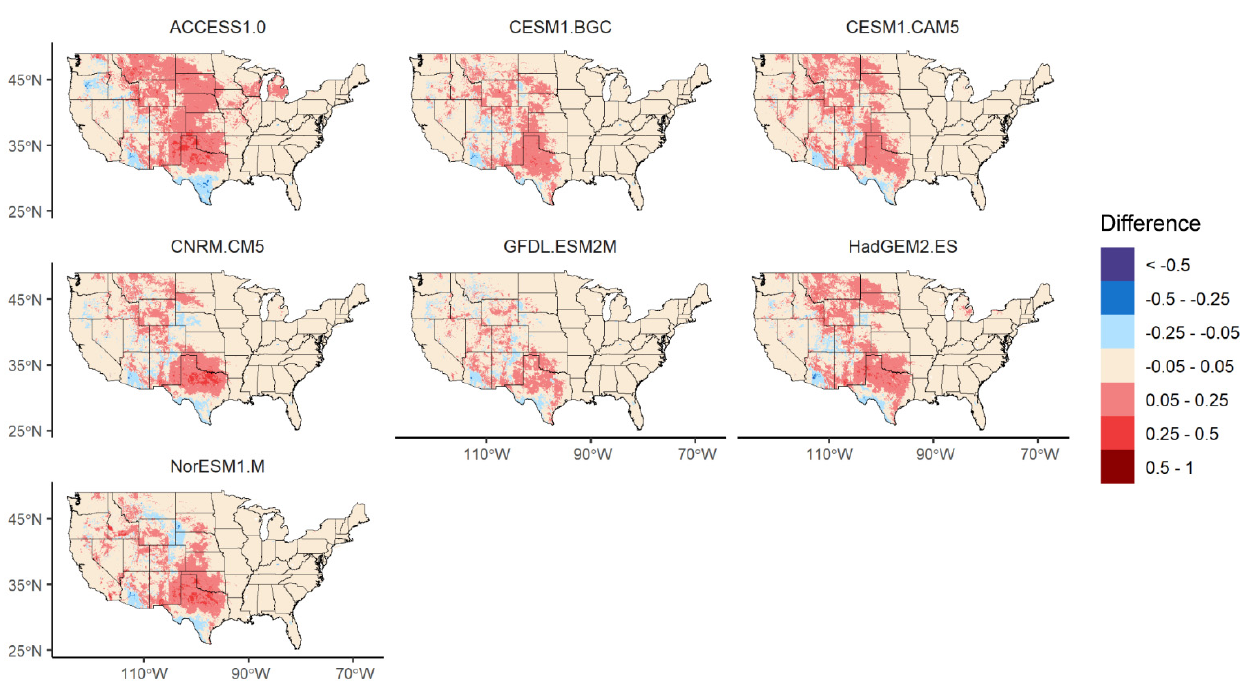
Figure 5. The difference in relative occurrence rates (projected–current) using climate projections from the RCP 4.5 emission scenario from current climate estimates for each general circulation model selected for analysis and described in Table A2.